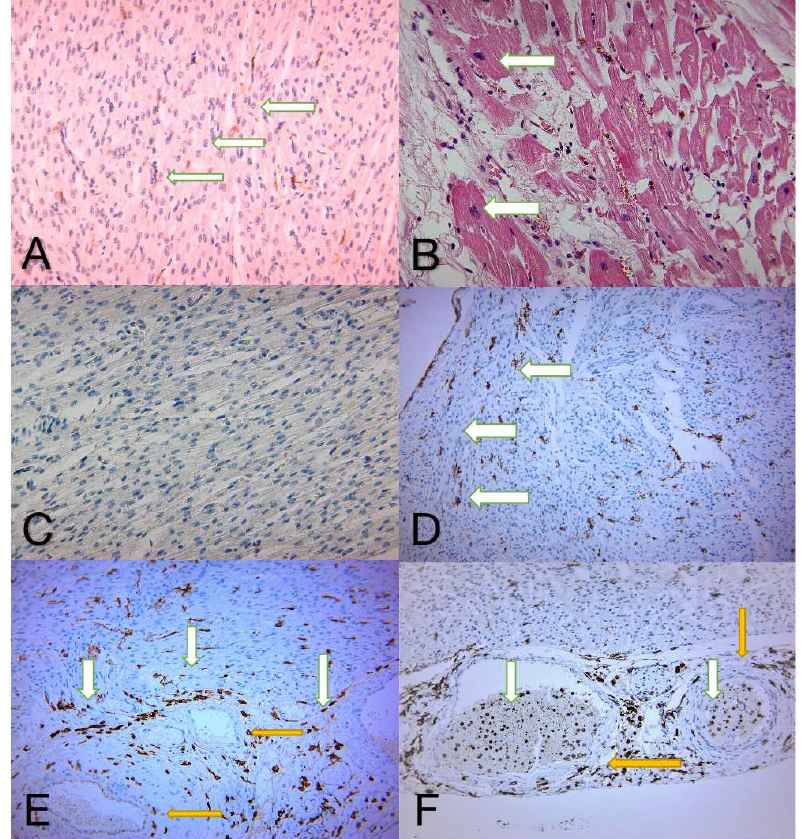
Figure 1. ( A , B ) H&E normal aspects of the control group, showing cardiac muscle fibers with in- terstitial edema and inflammatory infiltrate. ( A ) Cardiac muscle fibers with small nuclei located centrally—white arrows (magnification 100×). ( B ) The nuclei of the fibers are enlarged in volume, revealing cellular suffering—white arrows (magnification 200×). ( C ) The negative expression of CD14 in a specimen belonging to the control group. The causes of death in the control group were not related to heart disease (magnification 100×). ( D ) Immunohistochemical image of numerous myocardial fibers with inflammatory cells intercalated, with the membrane marked in brown, showing low CD14 expression (<10%)—white arrows (magnification 40×). ( E ) Immunohistochem- ical image of the myocardial cells, with numerous inflammatory cells intercalated and membra- nous immune expression of CD14 marked in brown and white arrows. Its expression is revealed mainly on the macrophage membrane surface, but also minimally distributed on the neutrophil surface of mCD14. No expression is seen in the blood vessels—yellow arrows (magnification 40×). ( F ) Immunohistochemical image of a blood vessel located intramuscularly—yellow arrows. In the vessel’s lumen there can be noticed granular areas of extracellular, soluble CD14 (brown color) along with monocytes and neutrophils (mCD14)—white arrows (magnifications 40×).